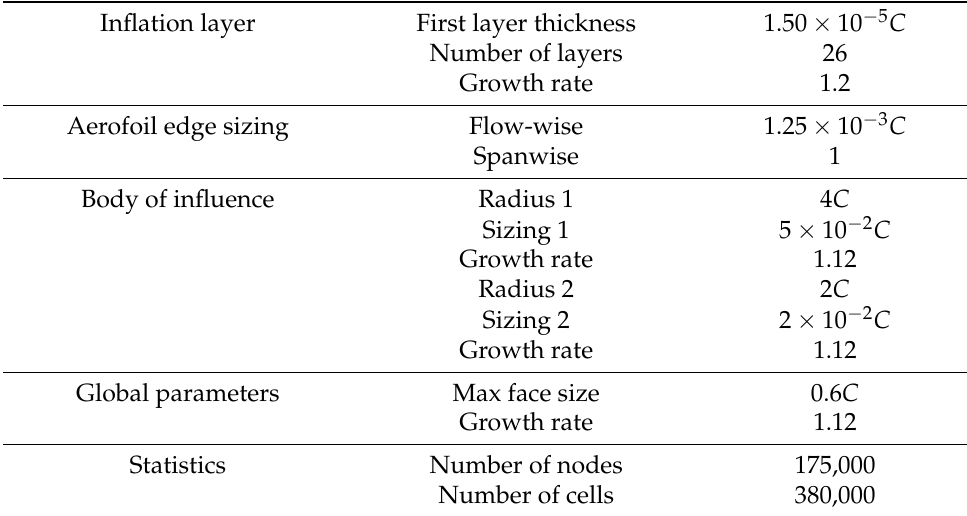
Table 1. Mesh parameters.